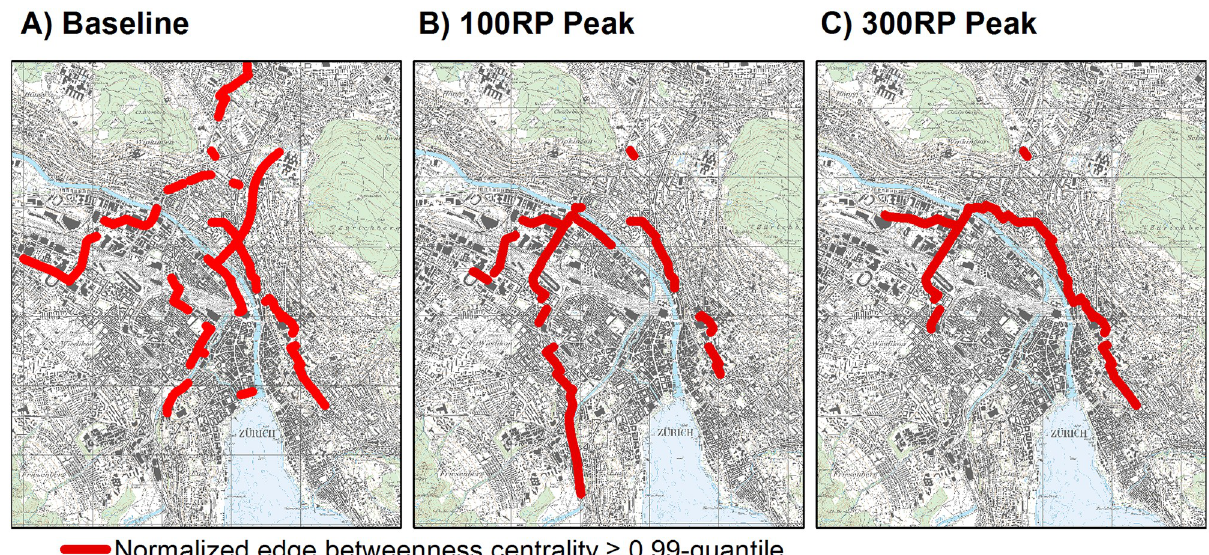
Fig 2. Spatial distribution of edge betweenness centrality in Zurich network of roads at least 3 m wide, under the following scenarios: Baseline conditions, peak flood within 100-year return period, or peak flood within 300-year period. For each network edge, EBC was evaluated by dividing number of shortest paths through edge by total number of shortest paths within network. Values of edge betweenness were normalized with (N)(N-1), where N was number of nodes under baseline conditions. Figure presents values equal to or larger than 0.99-quantiles. Reprinted from National Map 1:25000 on sheet 1091 under a CC BY license, with permission from the Federal Office of Topography Swisstopo (original copyright 2019).